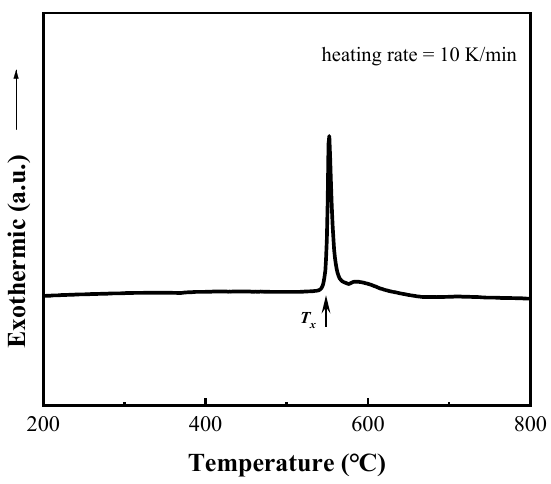
Figure 2. DSC curve of the raw FeSiBCr amorphous powder with a heating rate of 10 K/min. The XRD patterns of phosphated powders after annealing at different temperatures for